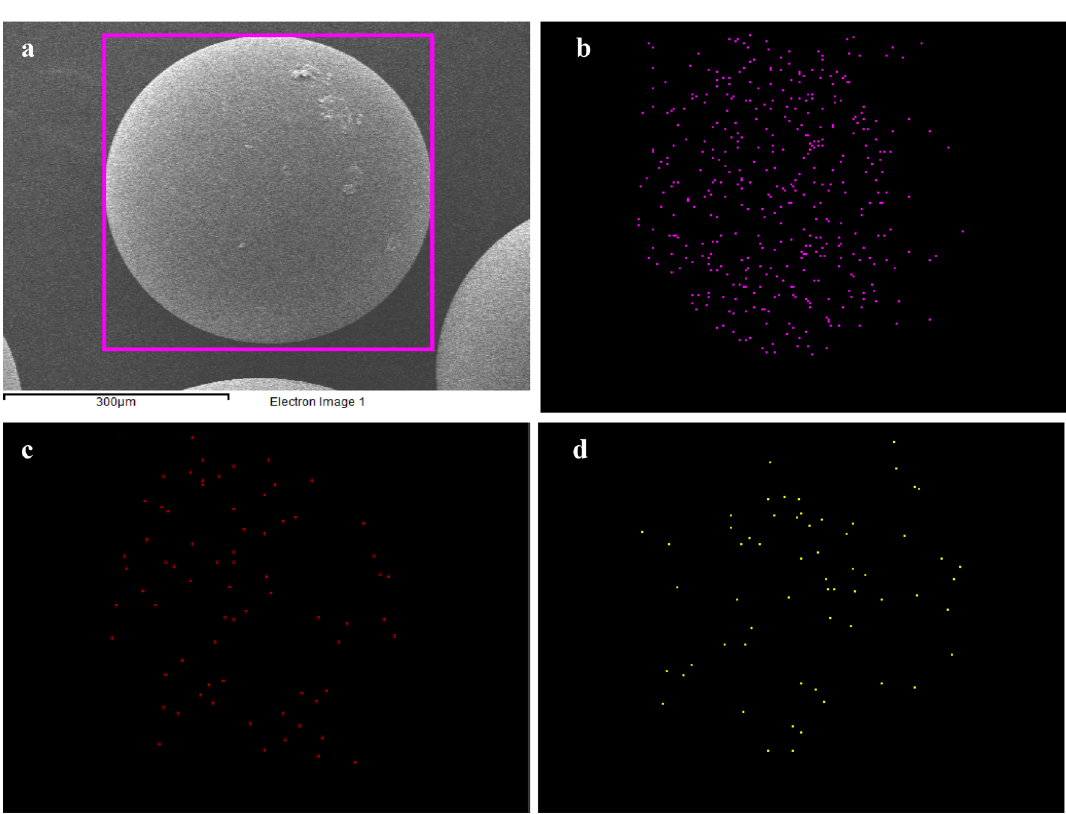
outer surface of the resin after impregnation that affects the morphology of the resin. The presence of these micro granules fixed on the surface of XAD-7 resin indicates that it is functionalized by the CYANEX-272 extractant. The SEM images of the SIR after Ce(ΙΙΙ) and La(ΙΙΙ) adsorption and corresponding p, La, and Ce elemental mappings are presented in Fig. 3. As observed a large amount of phosphorus was diffused on the surface of XAD-7 resin after impregnation with CYANEX-272 extractant. The homogeneous distribution of La and Ce ions on the SIR surface confirms their successful adsorption by impregnated XAD-7 resin 22 . The EDX image of the XAD-7 resin impregnated with CYANEX-272 after Ce(ΙΙΙ) and La(ΙΙΙ) adsorption is shown in Fig. 4. According to Fig. 4, the existence of the phosphorus (P) peak denotes the successful impregnation of the resin by the CYANEX-272 extractant. Also, the presence of Ce(ΙΙΙ) and La(ΙΙΙ) peaks indicates their uptake by the resin.